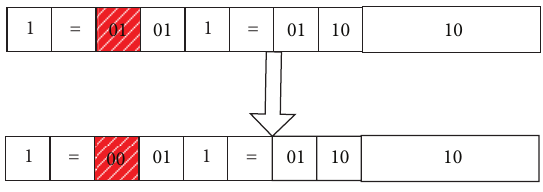
Figure 6: An example for weight mutation.